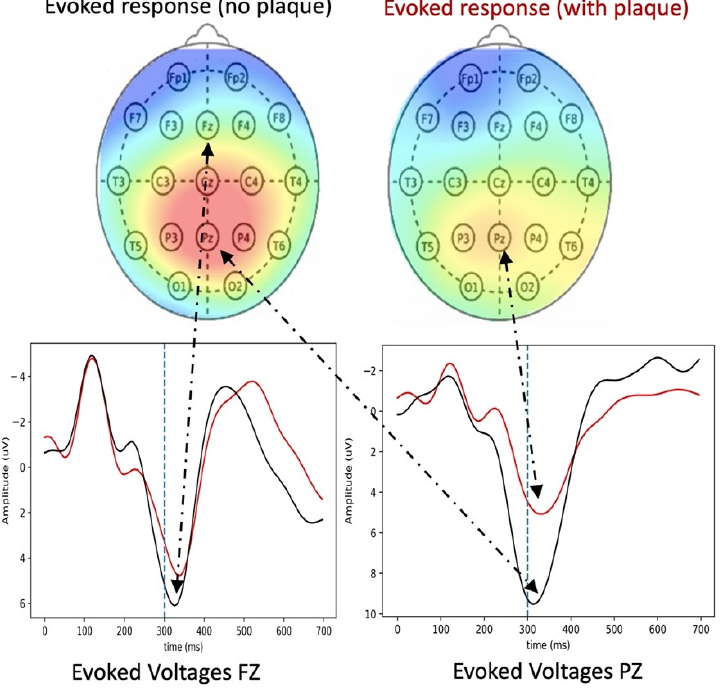
Figure 1. P300 response for patients with and without plaque. Top display shows P300 amplitudes (blue–red = 0–10 uV) across scalp locations and bottom shows response voltages as a function of post-stimulus time for two scalp locations (frontal Fz and parietal Pz). Arrows illustrate the link to scalp locations (bottom plots) where the black curves represent voltages averaged for all patients without plaque and the red curve is the average for all patients with plaque. Note that it takes around 300 ms for the brain to cognitively distinguish the novel signal (vertical blue lines) as indicated by the prominent positive downward peak. This study utilizes the depth and timing of this peak as dependent variables of interest. Here, it can be seen that the patients with plaque had on average a smaller and slower parietal (but not frontal) P300 response than those without.